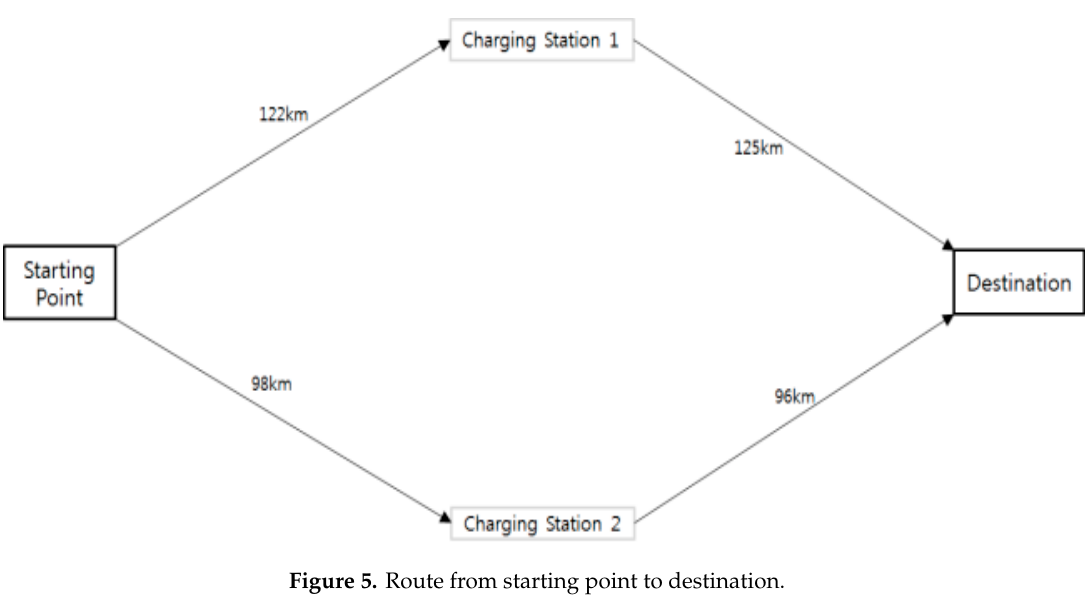
Table 1. The simulation scenario with dynamic pricing.